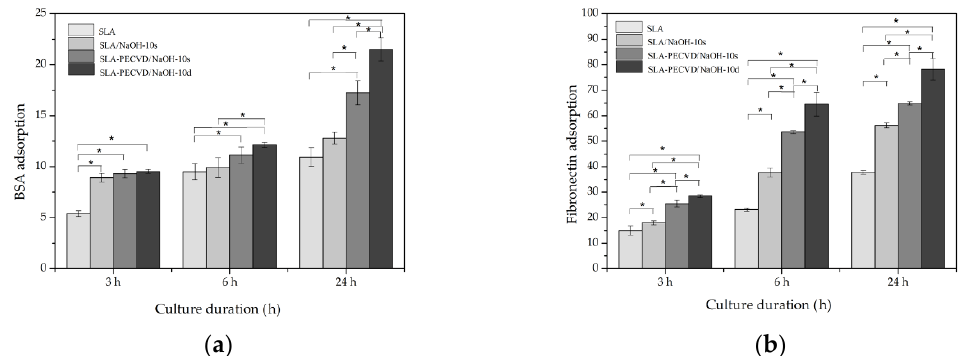
Figure 7. The results of protein adsorption capacities for bovine serum albumin (BSA) ( a ) and human fibronectin (Fn ) ( b ). *: p < 0.05, indicating a statistically significant difference among the groups.